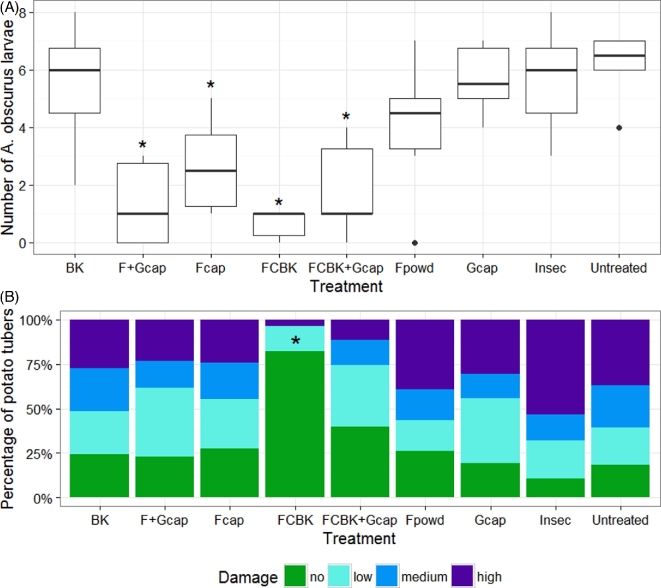
Number of A. obscurus larvae per treatment retrieved from pots initially receiving 10 larvae (A) and levels of potato tubers damage in percentage of total number of tubers harvested per treatment (B): no (0 holes per tuber; SE = 7%–13%), low (1–2 holes per tuber; SE = 4%–10%), medium (3–5 holes per tuber; SE = 0%–10%), high (>4 holes per tuber; SE = 4%–14%), n = 2 to 10 potato tubers per pot. Asterisk indicates significant differences to untreated control (P ≤ 0.05).